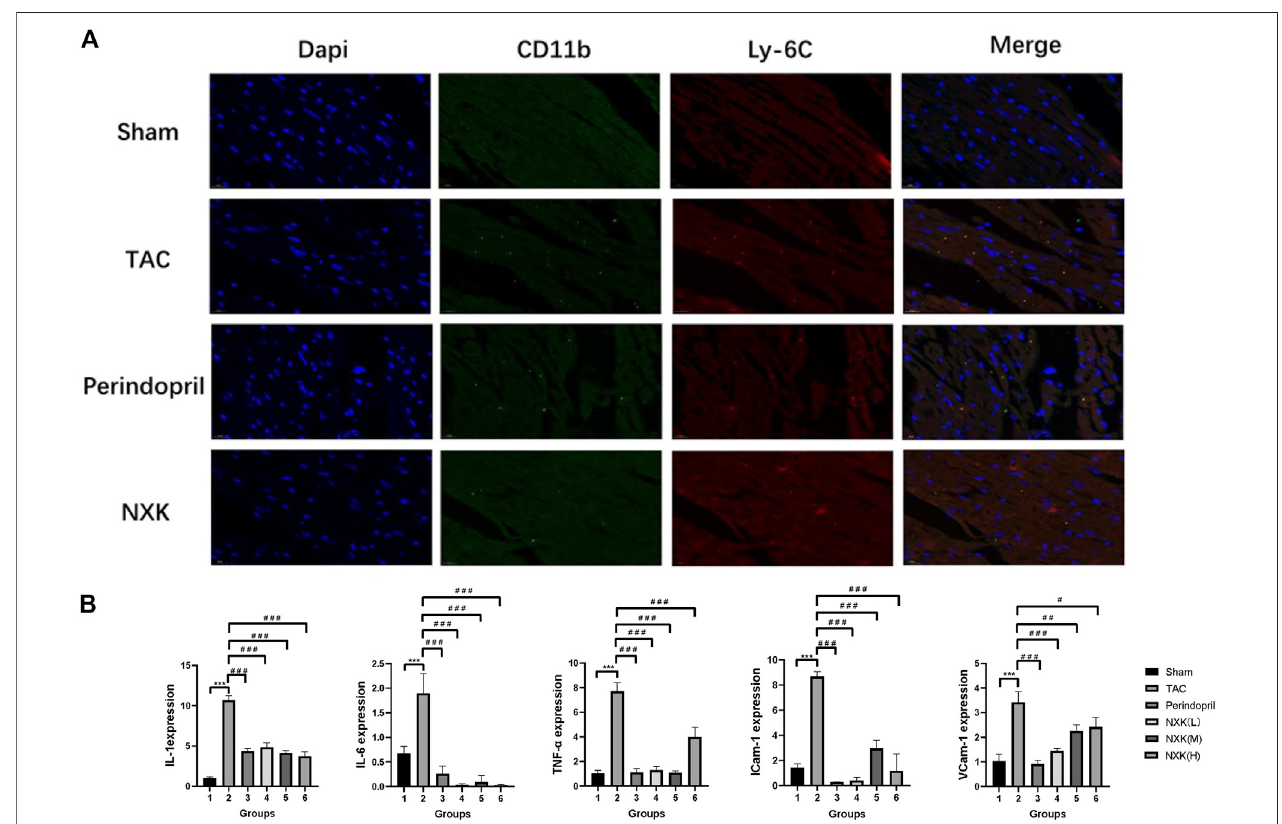
FIGURE3| NXKreducesthein fl ammationduetoheartfailurebyinhibitingthein fi ltrationofpro-in fl ammatorymonocytes/macrophages. (A) Representativeimages of heart tissue from the sham, TAC, perindopril, and NXK groups. DAPI staining (blue), CD11b (green), and Ly6c (red) are indicated ( n = 6 per group). (B) mRNA expression levels of IL-1, IL-6, TNF- α , ICAM-1, and VCAM-1 quanti fi ed by RT-PCR ( n = 10 per group). Values are shown as means ± SD, compared to the sham group * p < 0.05, ** p < 0.01, *** p < 0.001, compared to the Tac group # p < 0.05, ## p < 0.01, ### p < 0.001.